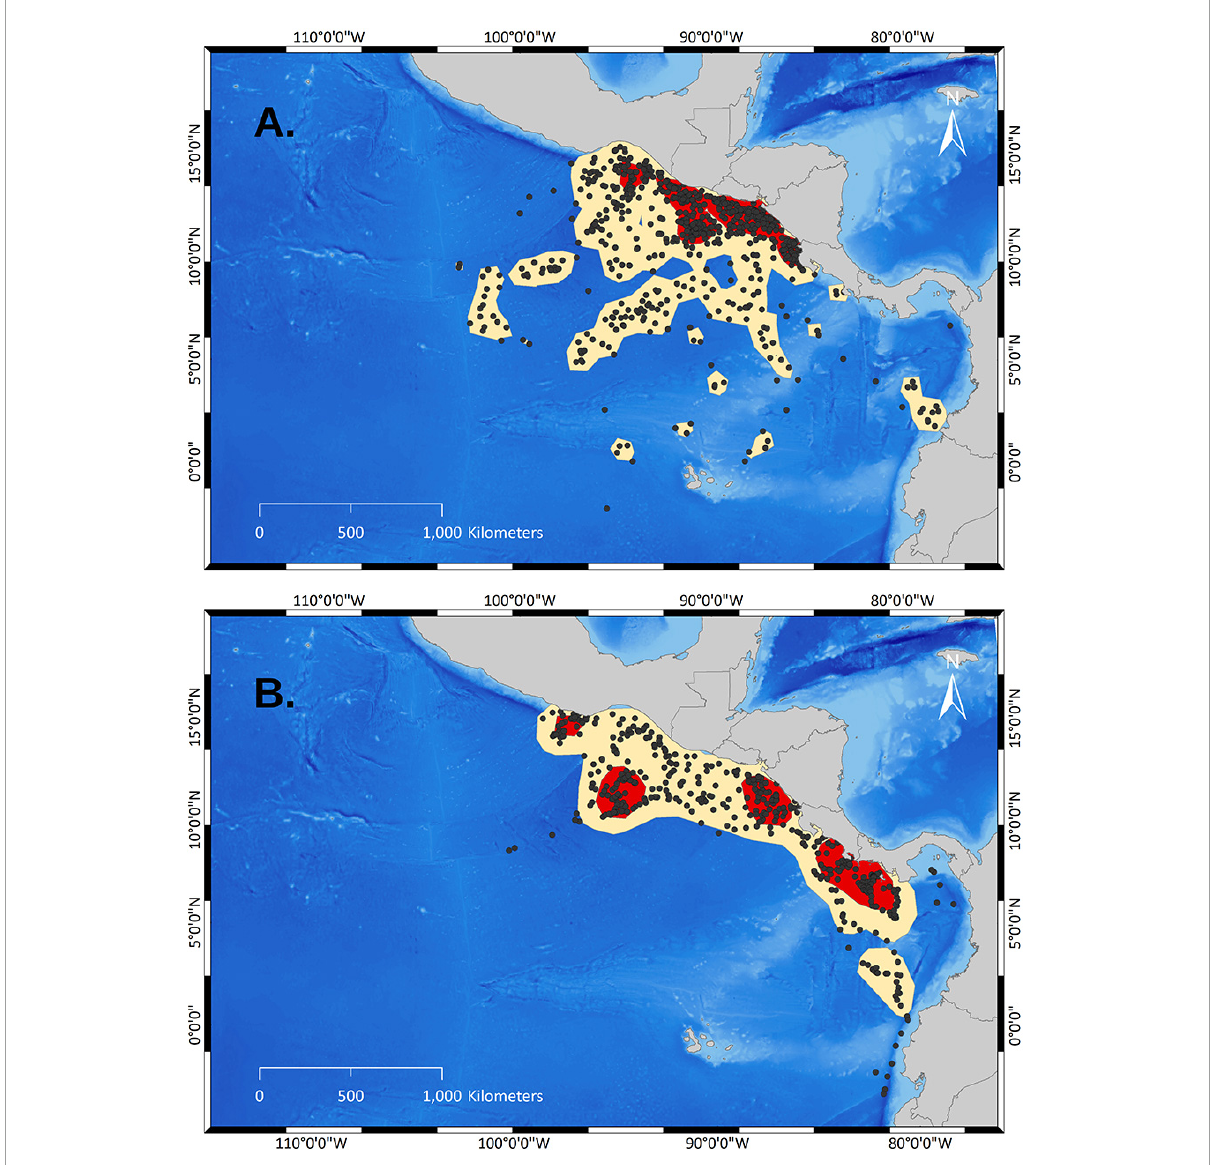
FIGURE3 Comparison of UDs from arribada and solitary olive ridley females. Red polygons demark PVC 50 (=core areas) and sand-colored polygons demark PVC 95 based on KDEs. (A) Locations and UD of arribada females. (B) Locations and UD of solitary